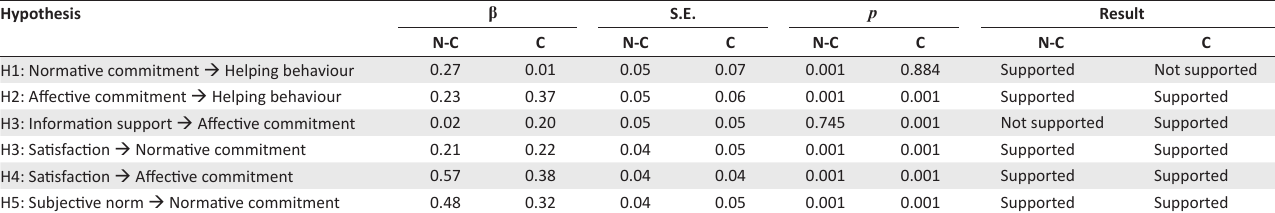
TABLE 4: Hypotheses testing